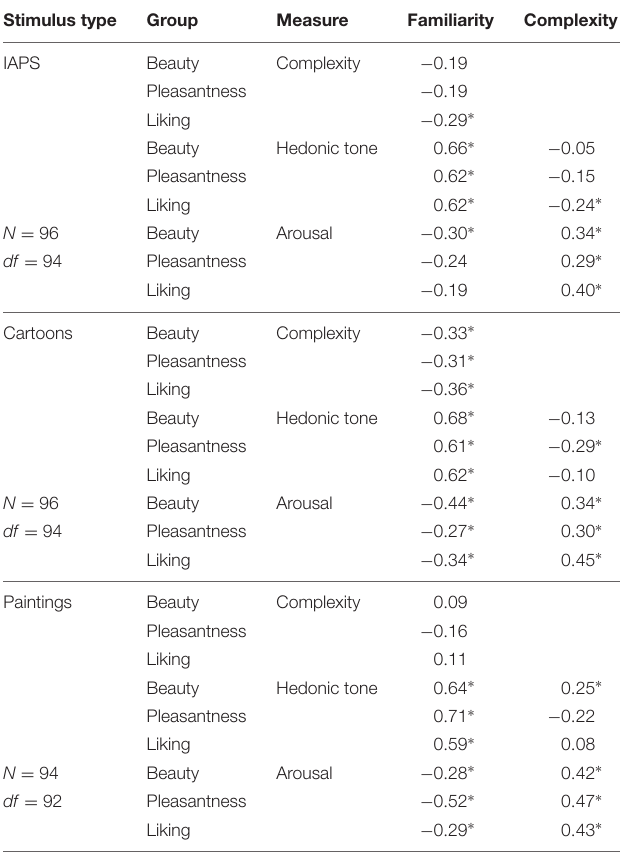
TABLE 3 | Spearman’s rank order correlations between measures of familiarity, complexity, arousal and measures of hedonic tone in response to IAPS pictures, cartoons and paintings.